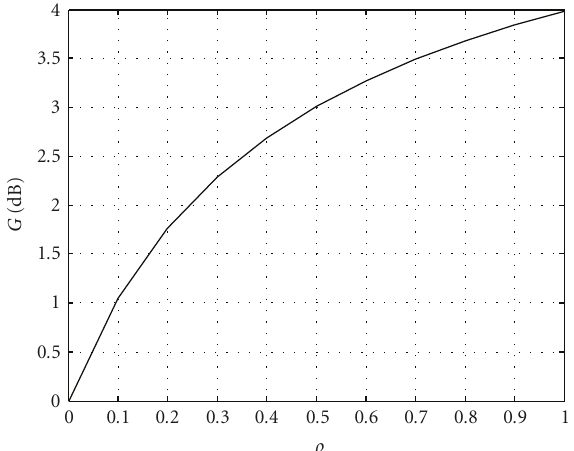
Figure 6: Coding gain obtained with RA Precoded in relation to RA Alamouti, for K × 1 × 1 system.